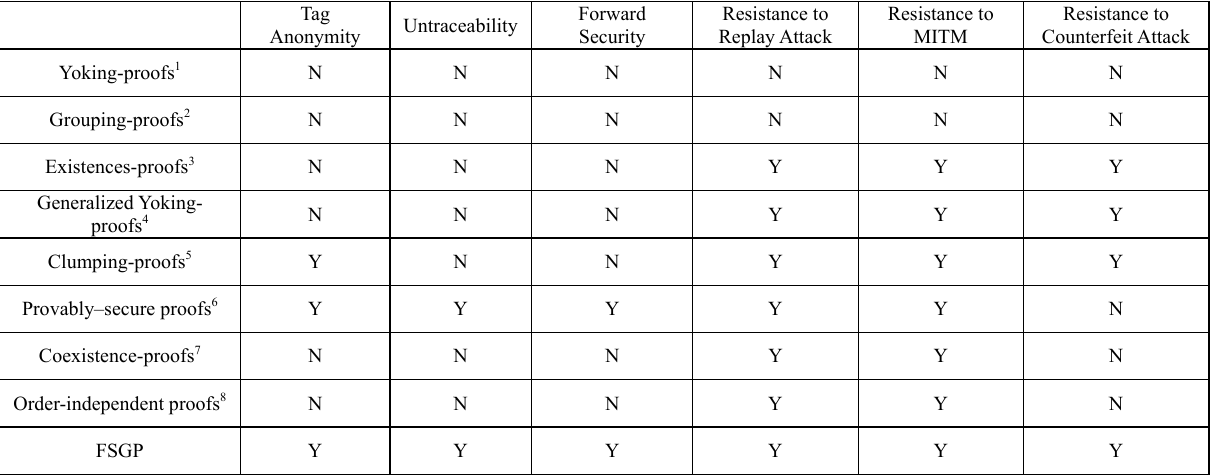
Table 2. Security comparison between FSGP and related grouping-proof